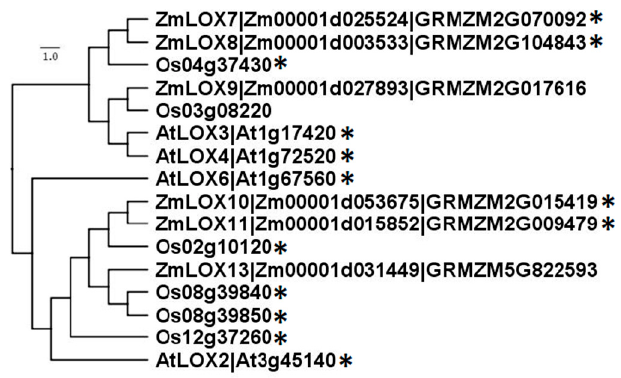
Figure 4. Amino acid sequences of 13-LOX family members from Arabidopsis , maize, and rice compared with ClustalX and visualized with Figtree. Gene labels follow established nomenclature from Arabidopsis [53], maize [51], and rice [52]. * denotes predicted CTP by ChloroP.